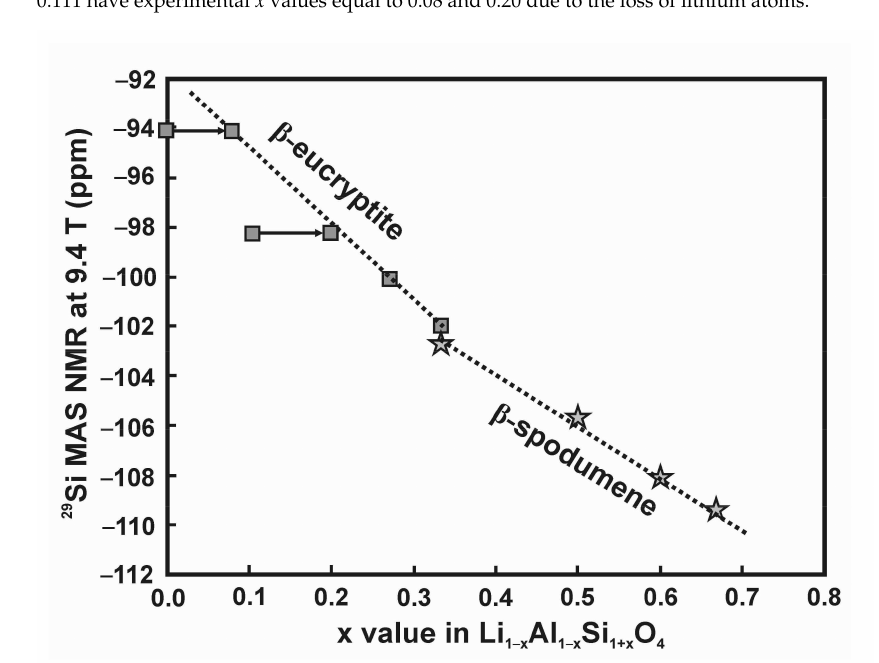
Figure 5. Correlations between the center of gravity of the 29 Si spectra with the x value in the solid-solution series of Li 1 − x Al 1 − x Si 1+x O 4 for four samples of β -eucryptite and four samples of β -spodumene. The nominal positions for x = 0.0 and 0.1 are corrected (arrows) from the loss of Li atoms by heating during the mineral